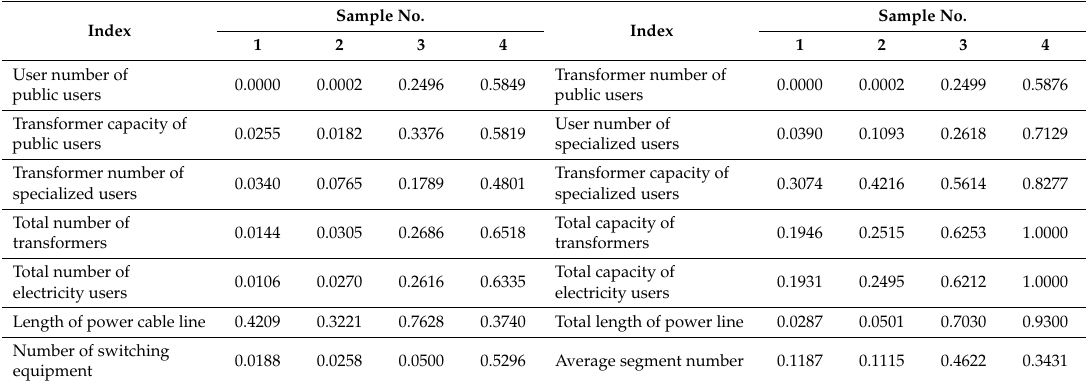
Table 7. Normalized data of typical